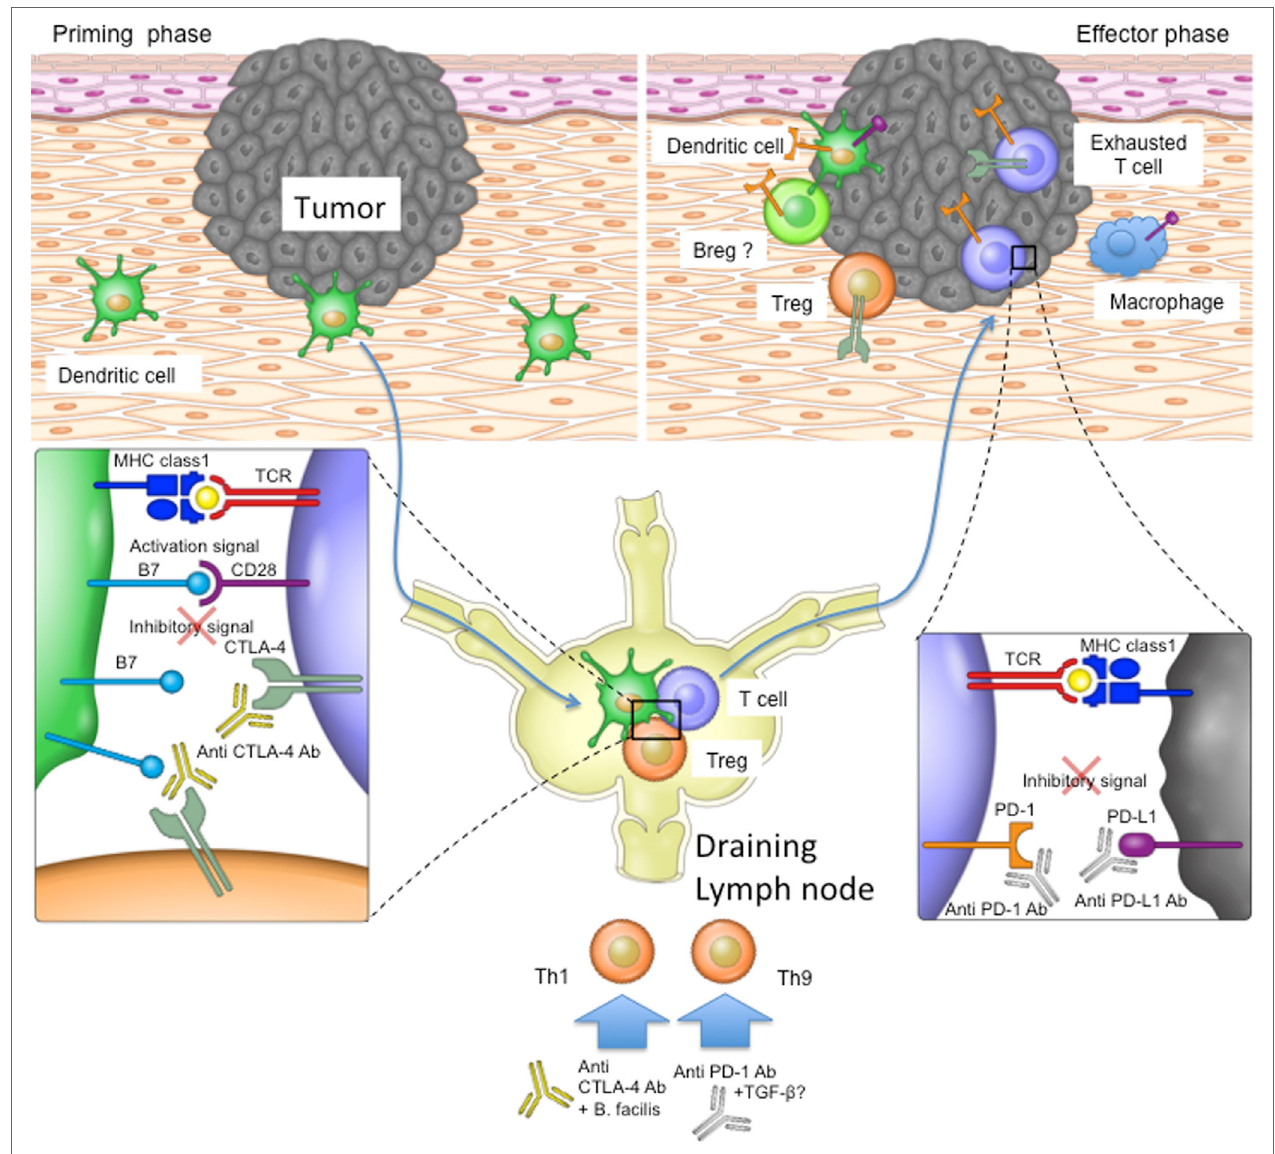
FiGURe 2 | The role of programmed cell death protein 1 (PD-1) and T-lymphocyte-associated protein 4 (CTLA-4) in the priming and effector phases of anti-tumor immune responses. For T cell priming, dendritic cells (DCs) sample antigen at the tumor site and transport it to the draining lymph nodes, where they present the antigens on their major histocompatibility complex (MHC) molecules to T cells. T cells become activated if their T cell receptors recognize and bind the antigen on MHC complexes and their CD28 costimulatory receptors bind CD80 and CD86 on DCs. CTLA-4 upregulation on T cells or bystander Tregs can interfere with the CD28 signal, as the former receptor binds CD80 and CD86 with higher affinity. Once activated, T cells migrate to the tumor site in order to kill malignant cells. Tumors or bystander cells such as macrophages may, however, upregulate PD-L1 and therefore obstruct T cell function by inducing inhibitory intracellular signaling. Anti-CTLA-4 blocking antibody may therefore restore T cell priming in the lymph nodes, and the PD-1 signaling blockade may enable T cell effector function at the tumor site. Additionally, other cell types such as Breg cells and DCs in the tumor microenvironment may express PD-1 and therefore be affected by PD-1 blockade. PD-1 and CTLA-4 blockade may also affect T helper cell profiles directly or by influencing the